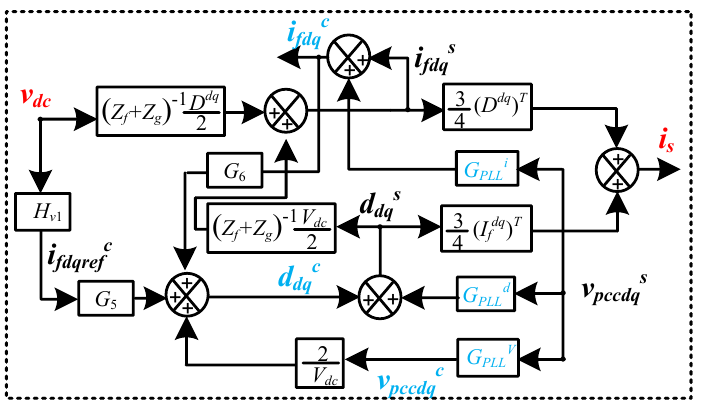
Figure 5. Small signal impedance model of GC operating in DCLV control mode with consideration of PLL dynamics.